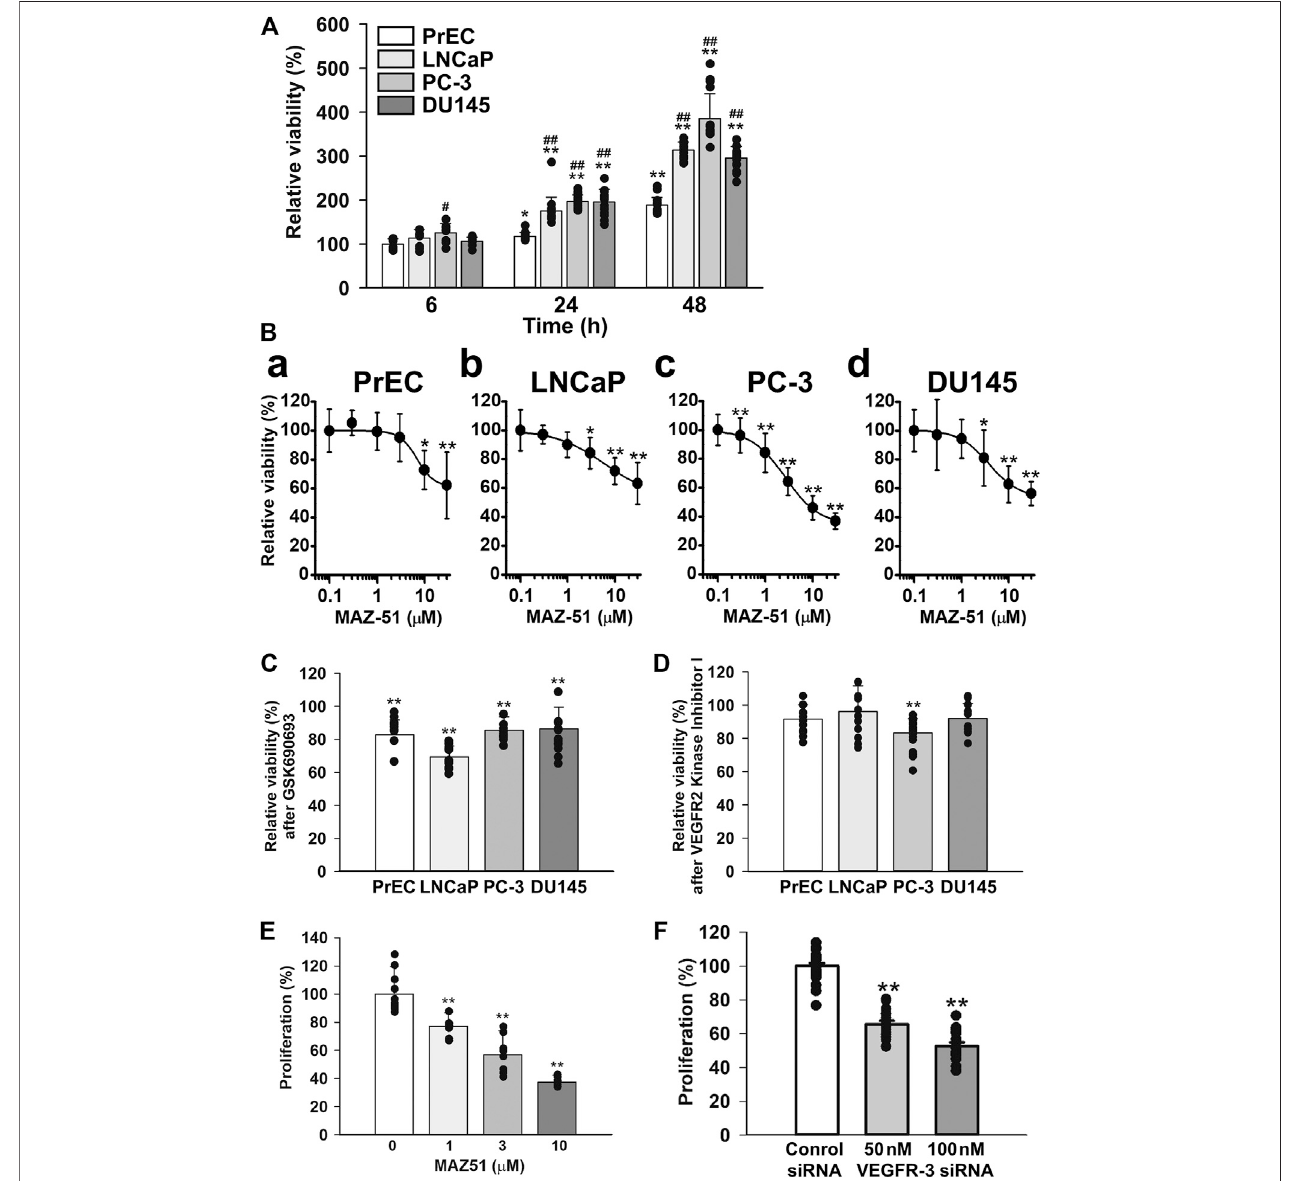
FIGURE 7 | Inhibitory effects of MAZ51 on the proliferation of human prostate cancer cells. The effects of MAZ51 on the cell viability and proliferation of human prostate epithelial PrEC cells and prostate cancer LNCaP, PC-3, and DU145 cells using MTT and BrdU assays, respectively. (A) Time-dependent cell growth of PrEC, LNCaP, PC-3, and DU145 cells ( n (cid:1) 9 – 16). (B) The effects of MAZ51 for 48 h on the viability of PrEC, LNCaP, PC-3, and DU145 cells ( n (cid:1) 8 – 34). The IC 50 values of MAZ51 on the viabilities of PrEC, LNCaP, PC-3, and DU145 cells were 7.0, 6.0, 2.7, and 3.8 μ M, respectively. (C) The effects of 100 nM GSK690693 (an Akt inhibitor)for48 hontheviabilityofPrEC,LNCaP,PC-3,andDU145cells( n (cid:1) 12 – 18). (D) TheeffectsofVEGFR2KinaseInhibitorIfor48 hontheviabilityofPrEC,LNCaP, PC-3,andDU145cells( n (cid:1) 12 – 24). (E) TheeffectsofMAZ51for48 hontheproliferationofPC-3cells( n (cid:1) 12). (F) Theeffectsof50and100 nMVEGFR-3siRNAfor48 h on the proliferation of PC-3 cells ( n (cid:1) 16 – 24). Data are presented as means ± S.D. * p < 0.05, ** p < 0.01 vs. 6 h, 0 μ M drug, or control siRNA; # p < 0.05, ## p < 0.01 vs. PrEC cells (Scheffé ’ s test following